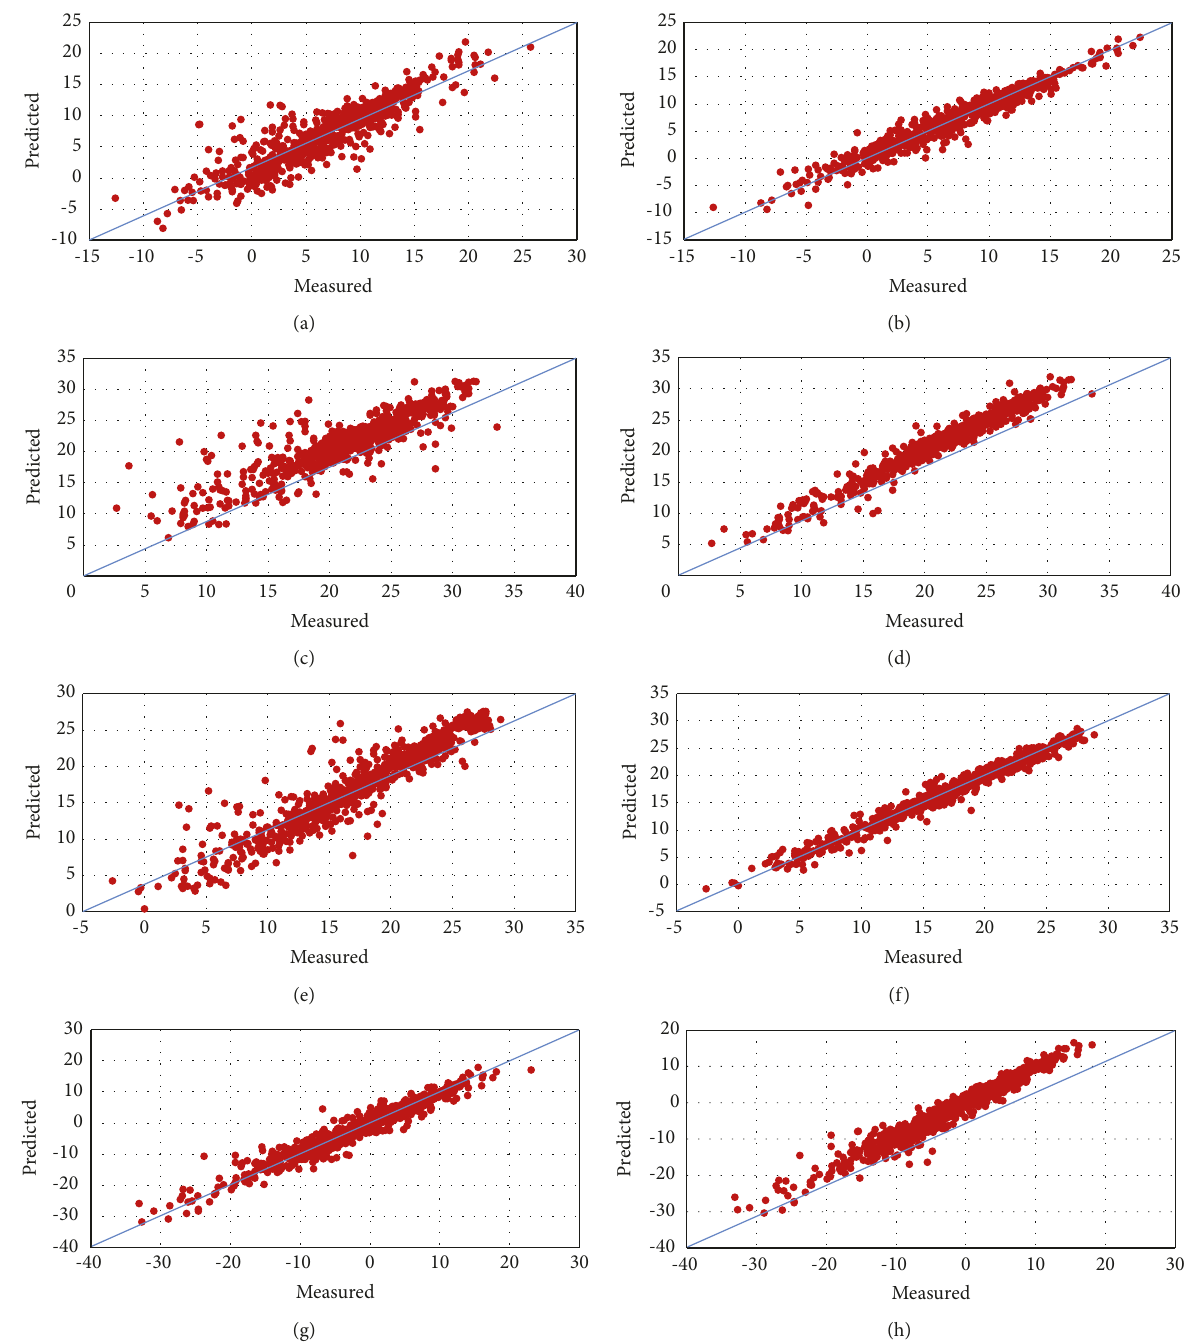
Figure 5: Scatter plots of measured and predicted values for the four days and the two methods, respectively. Two graphs in a row correspond to a certain day, and the graph on the left is plotted according to the results of the BME-hard method, while the graph on the right is plotted according to the results of the BME-both